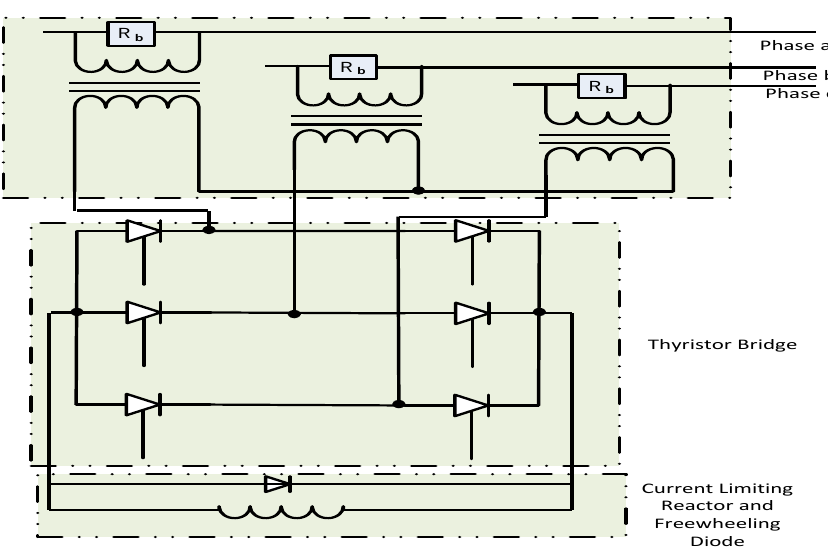
Figure 12. Transformer coupled bridge fault current limiter (BFCL).